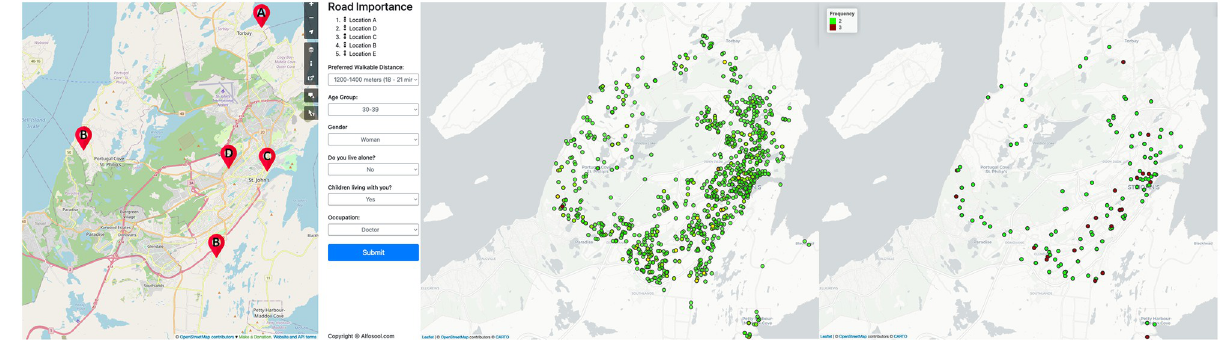
Fig 3. ALF–Score online crowd–sourcing platform. Our interactive web–based data collection platform on left (map generated by OpenStreetMap, screenshot taken from alfosool.com) has been deployed with road data from various cities in Canada. Displayed here shows the city of St. John’s, NL. Total 1050 (center 1 ) rankings were received from participants showing a well distributed data collection. Some locations were ranked multiple times (right 2 ) by the same or various participants. We can observe in our collected data the maximum number of conflicts is 3 per location with a very little occurrence. (Maps 1 and 2 are generated through RStudio [31] Version 1.2 using mapview package from rstudio.com with OpenStreetMap used as its base